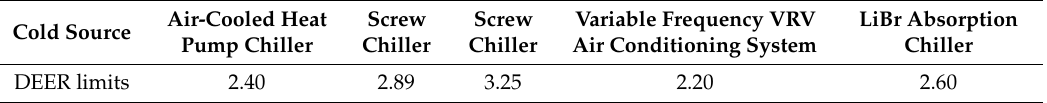
Table 3. The DEER limits of office buildings in